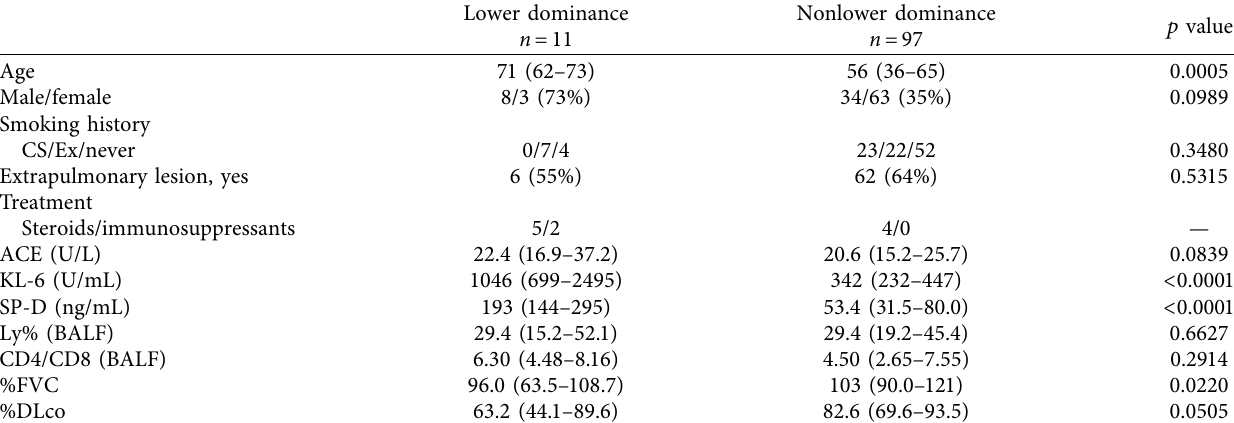
Table 1: Baseline characteristics in patients with lower and nonlower lung-dominant